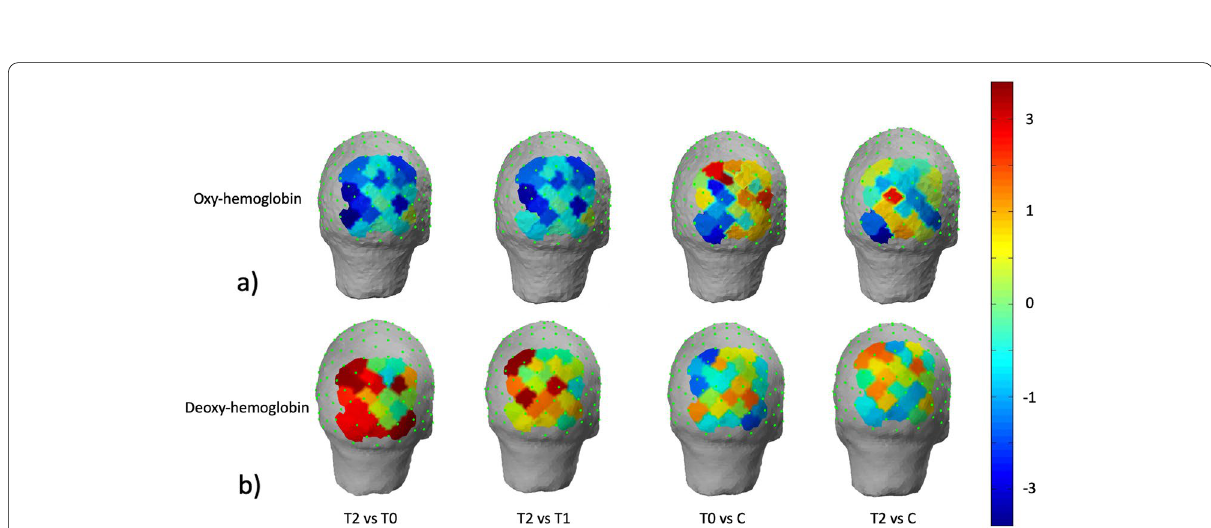
Fig. 8 T-statistic map of the brain regions wherein there are significant differences in oxyhemoglobin a) and deoxyhemoglobin b) concentrations for the comparisons: migraine patients at T2 vs migraine patients at T0, migraine patients at T2 vs migraine patients at T1, migraine patients at T0 and at T2 vs controls. Intense blue color expresses significant reduction evaluated with paired Student’s t test, red color significant increase in migraine patients in basal condition compared to controls with the unpaired Student’s t test. The scale refers to t